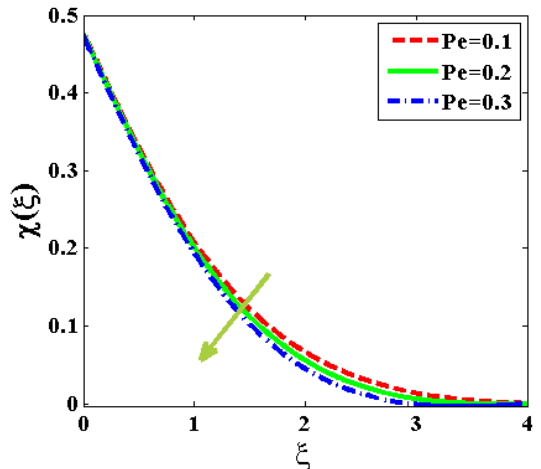
Figure 27. Outlines of 𝜒 at diverse quantities of 𝑃𝑒 .